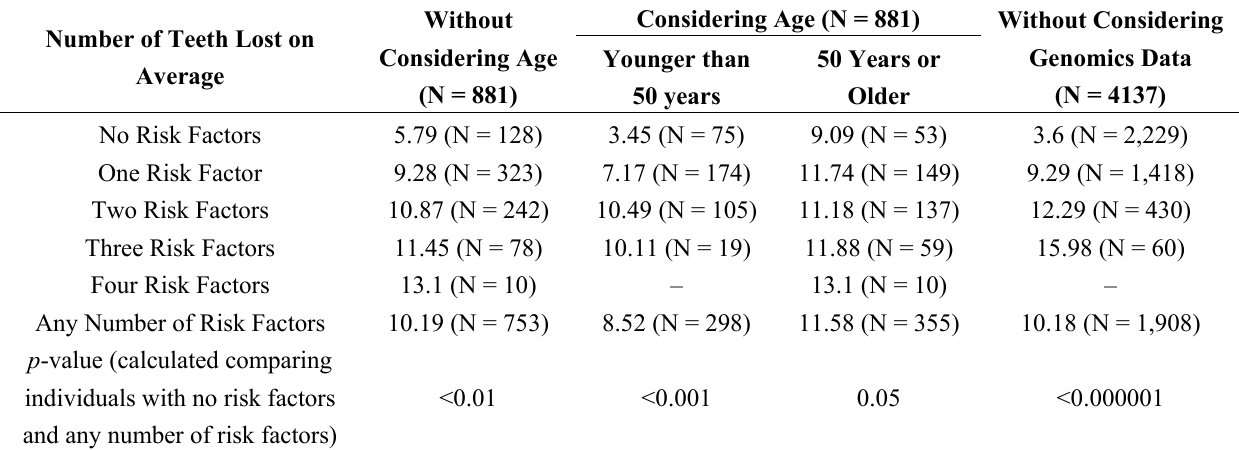
Table 2. Accumulated Risk Factors and Tooth